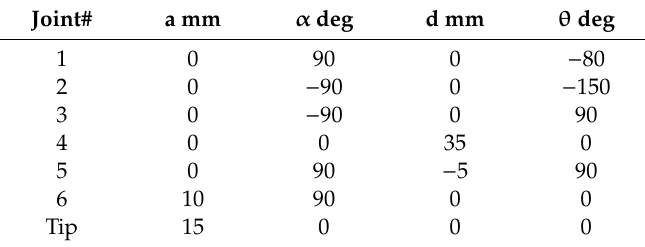
Table 7. Denavit–Hartenberg (DH) parameter of Condition (D). Table 6. Denavit–Hartenberg (DH) parameter of Condition (D).